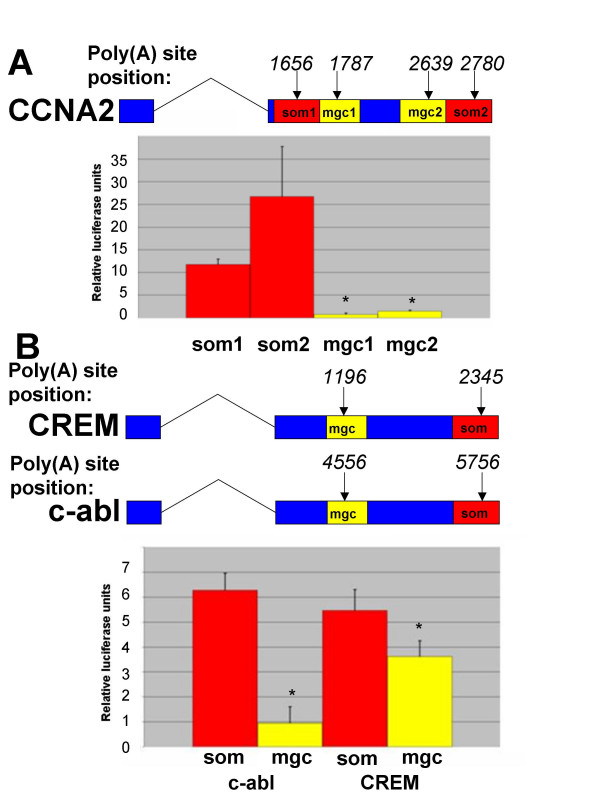
Somatic polyadenylation cassettes are preferred tomale germ cell-specific cassettes. A) At the top is a map indicating the positions of the various polyadenylation sites on the cyclin A2 mRNA. Above the diagram is the positions of the poly(A) sites used [27], and below is the name of the cassette. The diagram is approximately drawn to scale. Below, ATCC 3T3 cells (mouse embryonic fibroblasts) were transfected with plasmids containing somatic or male germ cell-specific cassettes indicated and extracts were assayed for activity as described in Figure 1. B) Same as A, but using CREM and c-abl cassettes. The poly(A) positions at the top are from [26, 28]. For both A and B, asterisks indicate significantly different from the respective somatic cassette as determined by Student's T-test (p < 0.01).